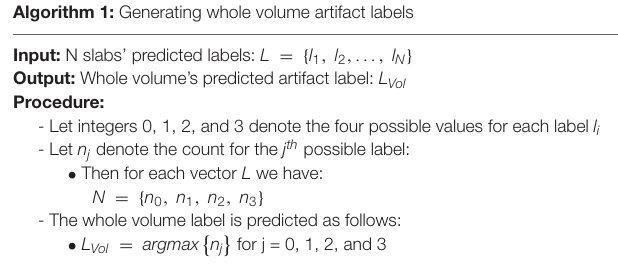
Algorithm 1: Generating whole volume artifact